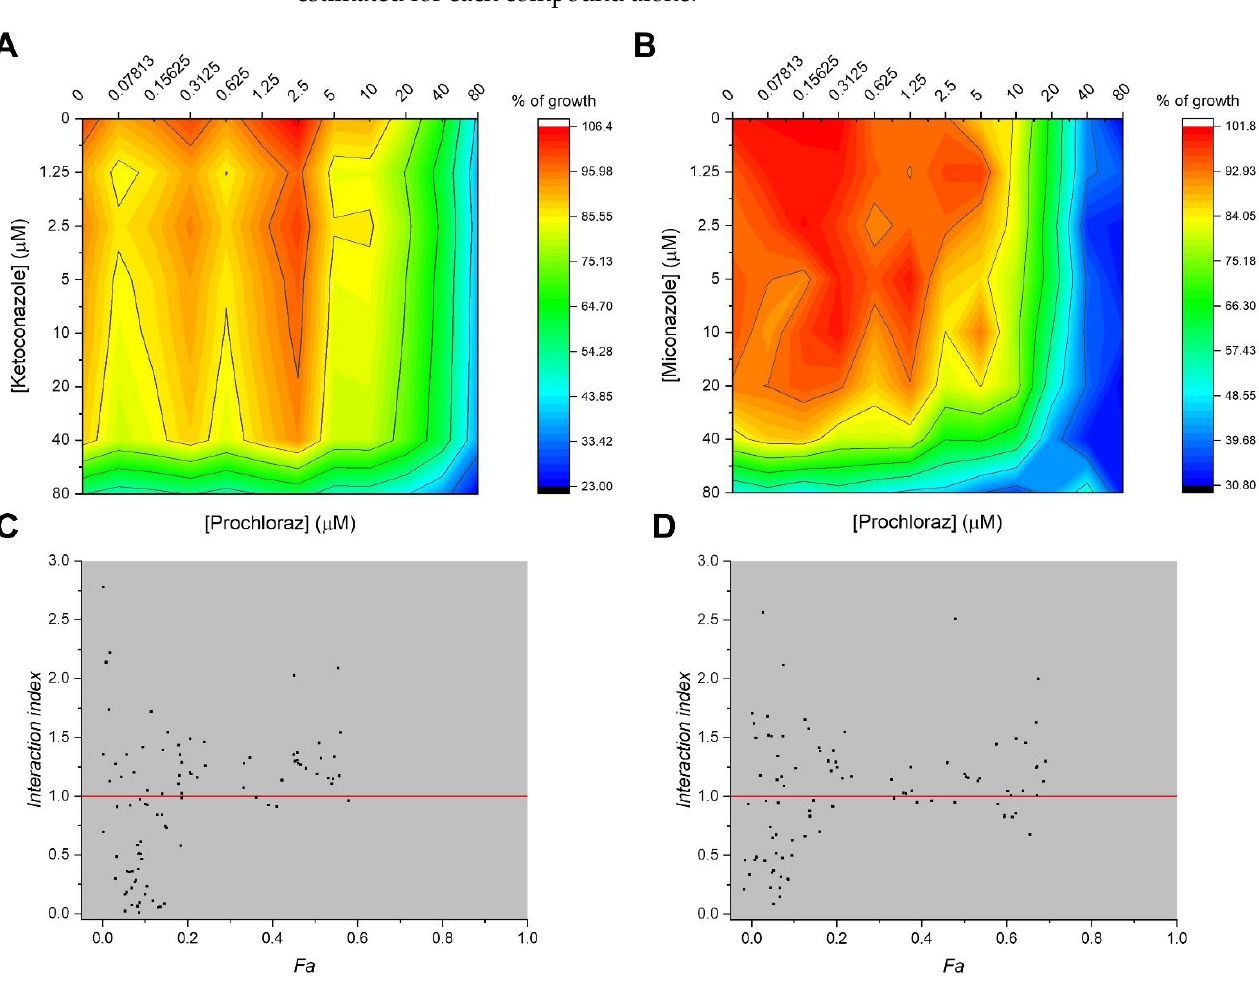
Figure 2. Synergistic interactions of PCZ with KCZ and MCZ in reducing cell viability and proliferation in TM4 cells. ( A , B ) Graphs representing the 2D-surface response ∆ E model ( ∆ E = E predicted – E measured ) and the experimental cell growth and viability obtained from the two-drug chequerboard assay using the MTT method in 96-well plates, for the binary combinations of PCZ/KCZ ( A ) and PCZ/MCZ ( B ). ( C , D ) Analysis of the combination index (CI) for PCZ/KCZ ( C ) and PCZ/MCZ ( D ); CI < 0 indicates a synergistic effect. Data represent the means of three independent experiments ± SE.